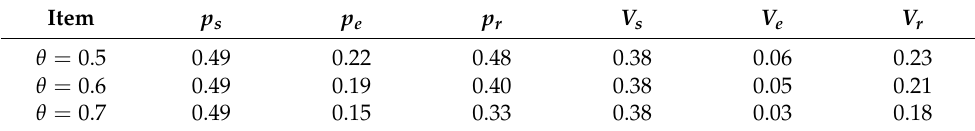
Table 6. Performance comparison under different channel strategies ( β = 0.25, p 0 = 0.8). Item p s p e p r V